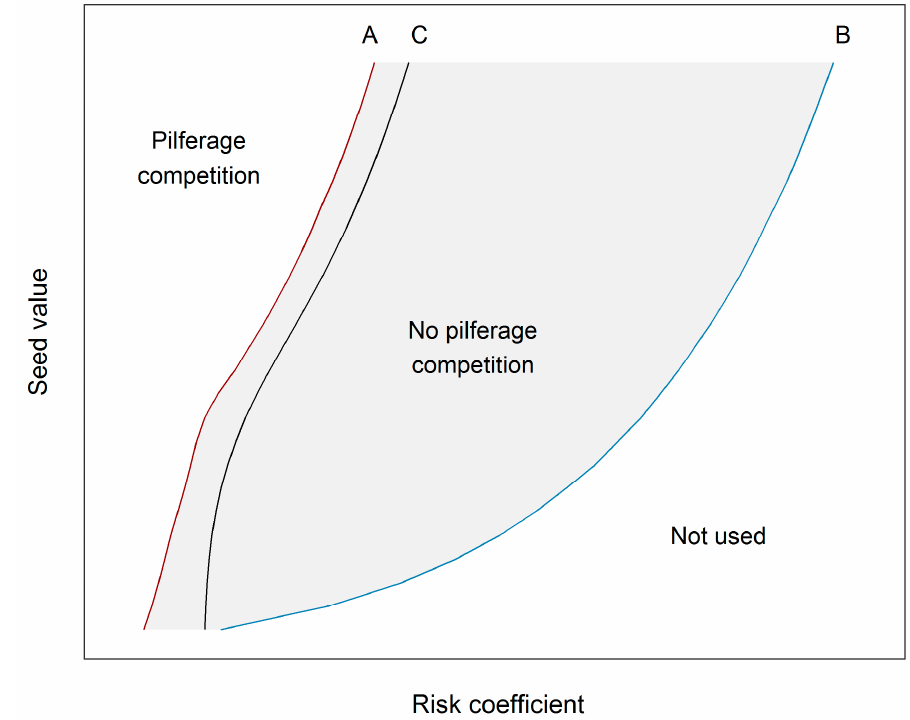
Figure 3. The phase-plane for perceived risk of foraging at a given location and the value of seeds cached at that location can be divided into three regions. Starting at the left, isopleth A (red line) marks the threshold at which the benefit of pilfering other animals’ caches intersects a hypothetical giving-up rate, so that pilferers should move elsewhere or switch foraging strategies. Cache retrieval remains profitable, but pilferage is not profitable, in the shaded region between isopleths A and B (blue line). To the right of isopleth B, retrieval also becomes unprofitable. Finally, isopleth C (black line) marks the combination of seed value and risk at which recovery advantages are maximized, based on a comparison of the benefit rates for retrieval and pilferage. Importantly, all three isopleths show positive relationships between seed value and risk, indicating that greater risks are needed to protect more valuable seeds. (This graph: 0.12 caches / m 2 with g [ i ,eat,kJ ] = 5, g [ own,recache,kJ ] = 0.1; curves show similar patterns for higher or lower cache densities but isopleths shift to the right or left, respectively).